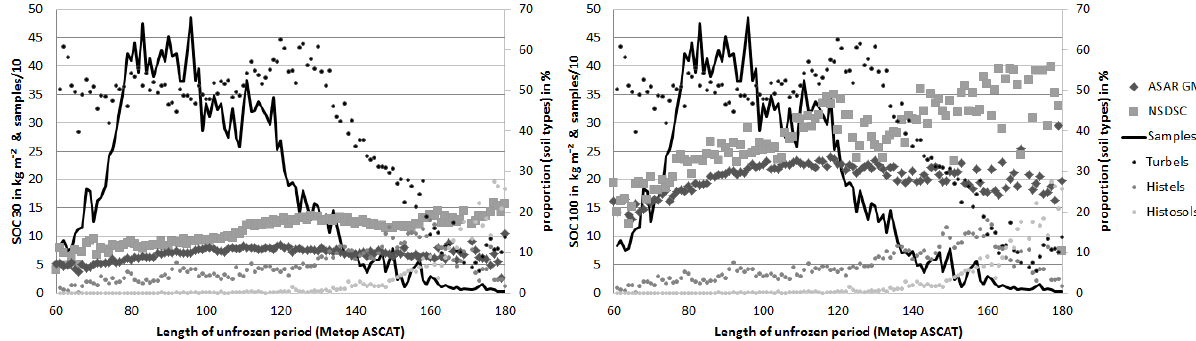
Figure 10. SOC from GM and the NCSCD (including mean % of turbels, histosols and histels) in comparison to unfrozen period length (source Paulik et al., 2012). Left: 0–100cm SOC; right: 0–30cm SOC. Values and soil type % have been averaged for class increments of 1 day. Samples correspond to pixels of 12.5km × 12.5km